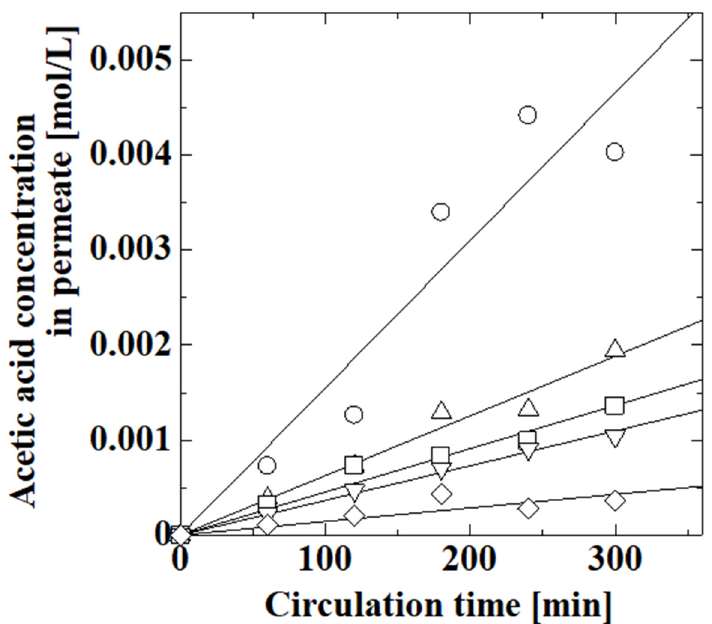
Figure 6. Effect of polymerization time on the permeation of acetic acid through PAA-coated alumina membrane for an acetic acid feed concentration of 0.1 mol/L: , uncoated alumina support; ∆ , PAA-coated alumina membrane with one polymerization; (cid:3) , PAA-coated alumina membrane with two polymerizations; ∇ , PAA-coated alumina membrane with three polymerizations; and ♦ , PAA-coated alumina membrane with four polymerizations.